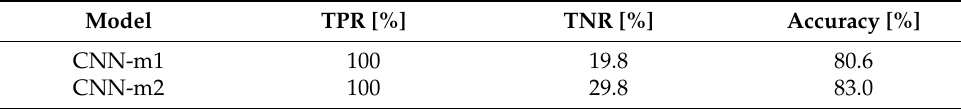
Table 11. Test results of the CNN-based anomaly detection models.